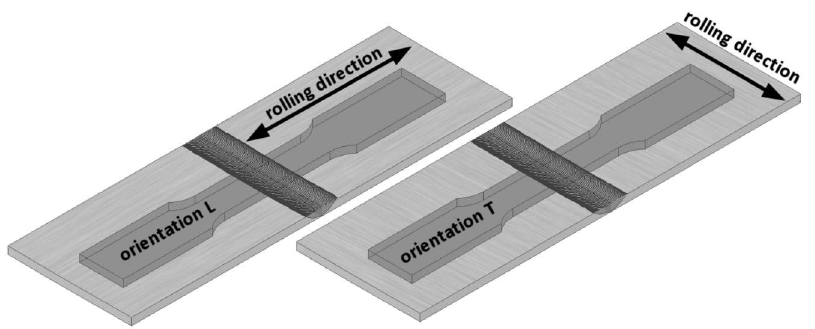
Figure 4. Schematic presentation of the longitudinal (L) and transversal (T) specimen orientation.